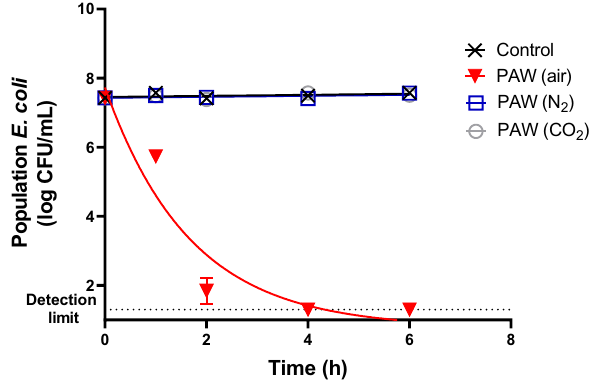
Figure 3. Inactivation of E. coli in relation to exposure time (h) to PAW (air), PAW (N 2 ) and PAW (CO 2 ). The exponential decay equation was used to analyse the dataset of the sample replicates of PAW (air) (R 2 = 0.913).